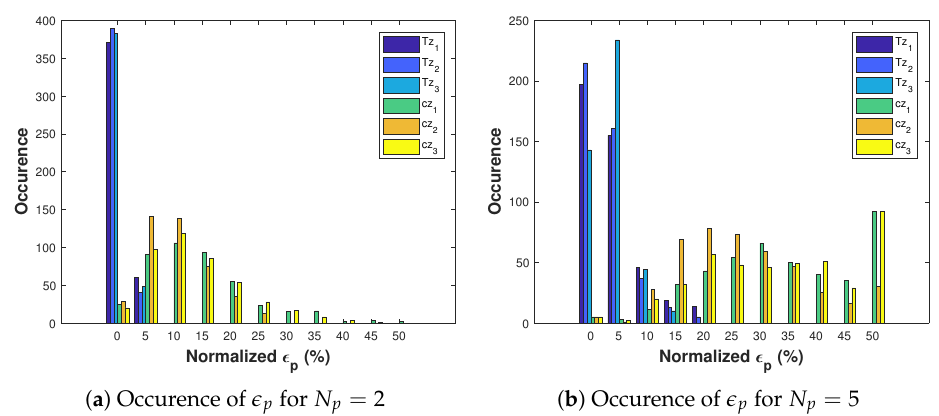
Figure 2. Validation of the modelling for the case-study.